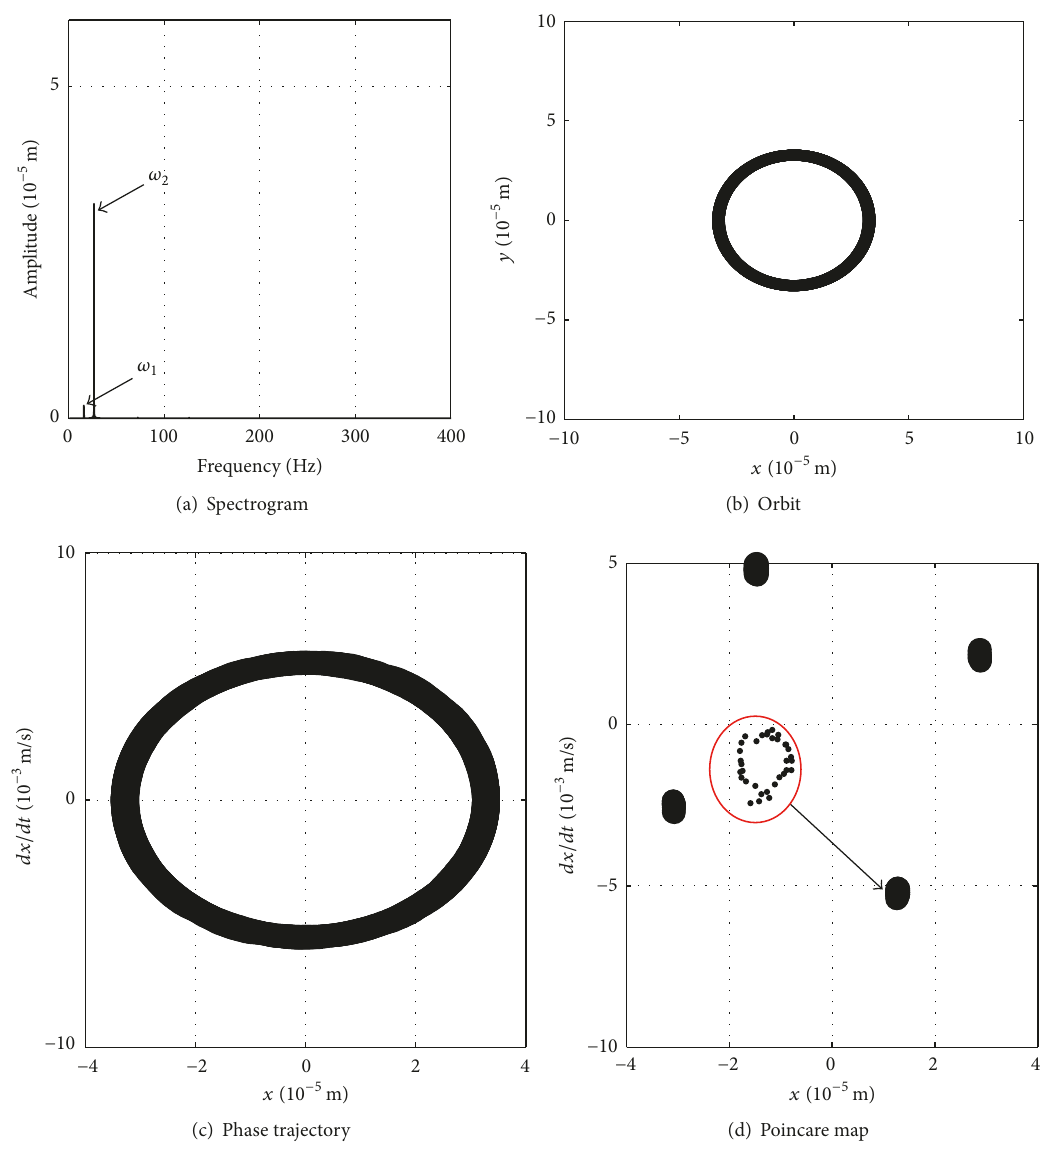
Figure 11: Response analysis of disk 2: 𝜔 1 = 102 rad / s and 𝜆 = 1.65